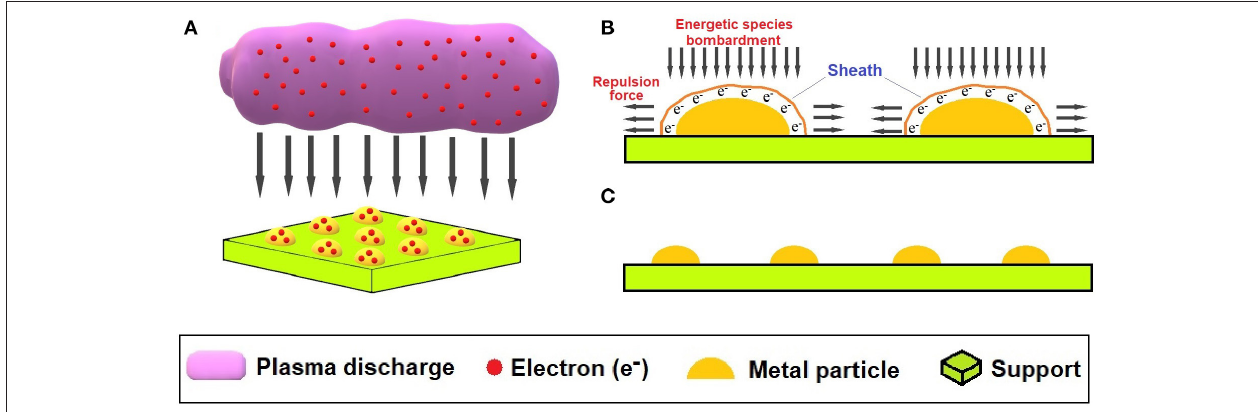
FIGURE 4 | Mechanism for obtaining a supported metal catalyst with smaller and highly dispersed active sites: (A) catalyst surface bombardment by energetic species and accumulation of electrons on metallic particles; (B) sheath formation and elongation of metallic particles due to repulsive forces; (C) fragmentation of metallic particles, resulting in smaller and more dispersed active